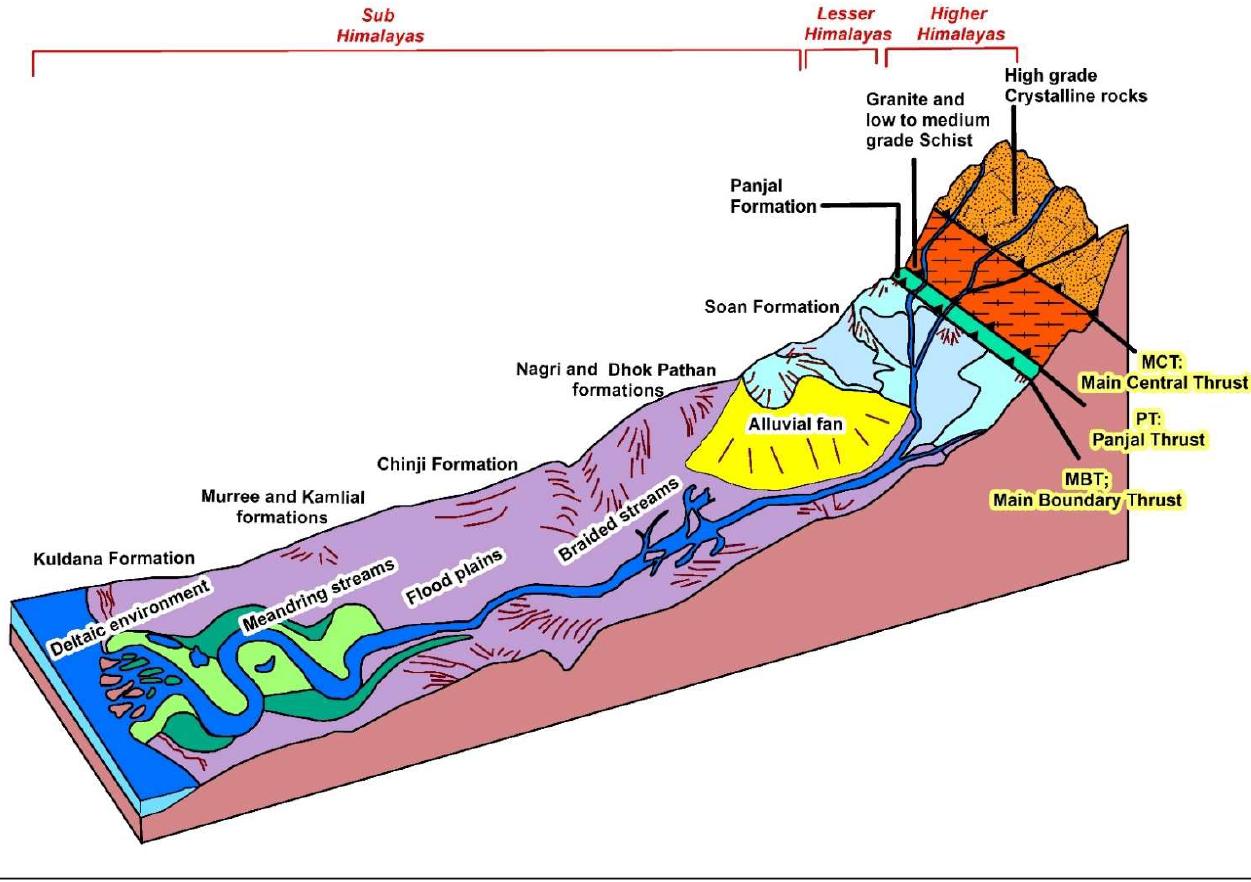
Figure 12. Generalized hypothetical depositional model of Himalayan Mollase based on previously published studies [2,4,20] and this study.